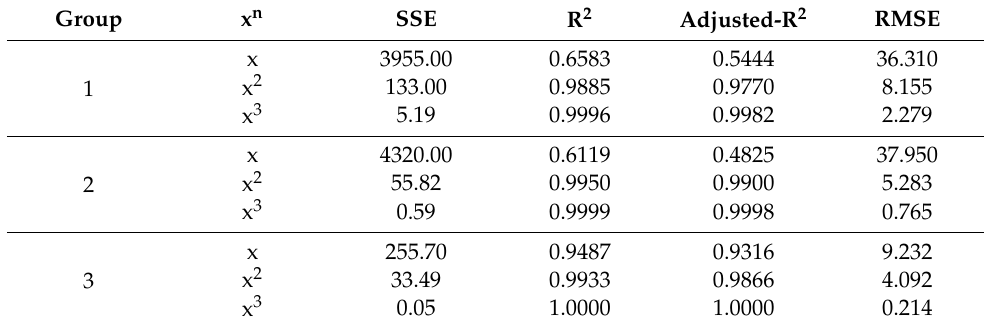
Table 2. Fitting results of different indices of x in the sagittal